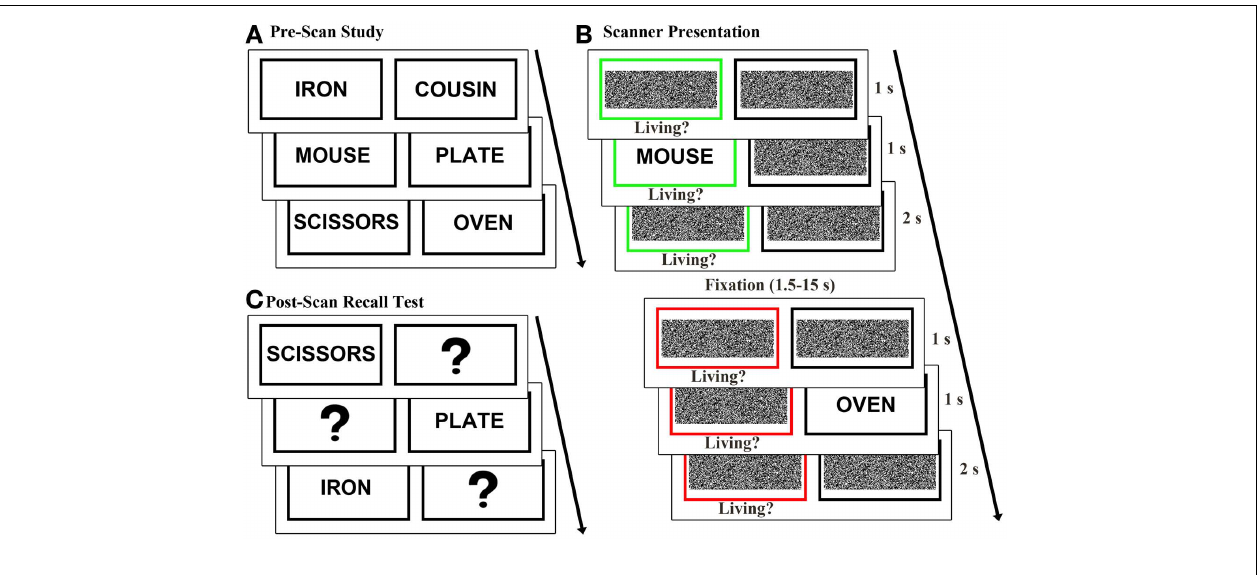
presented word as living or non-living. In the recall task a red box cued subjects to recall and classify the pair of the presented word. (C) In a post-scan recall test, subjects saw one word at a time from each pair and were asked to recall and vocally report the word’s